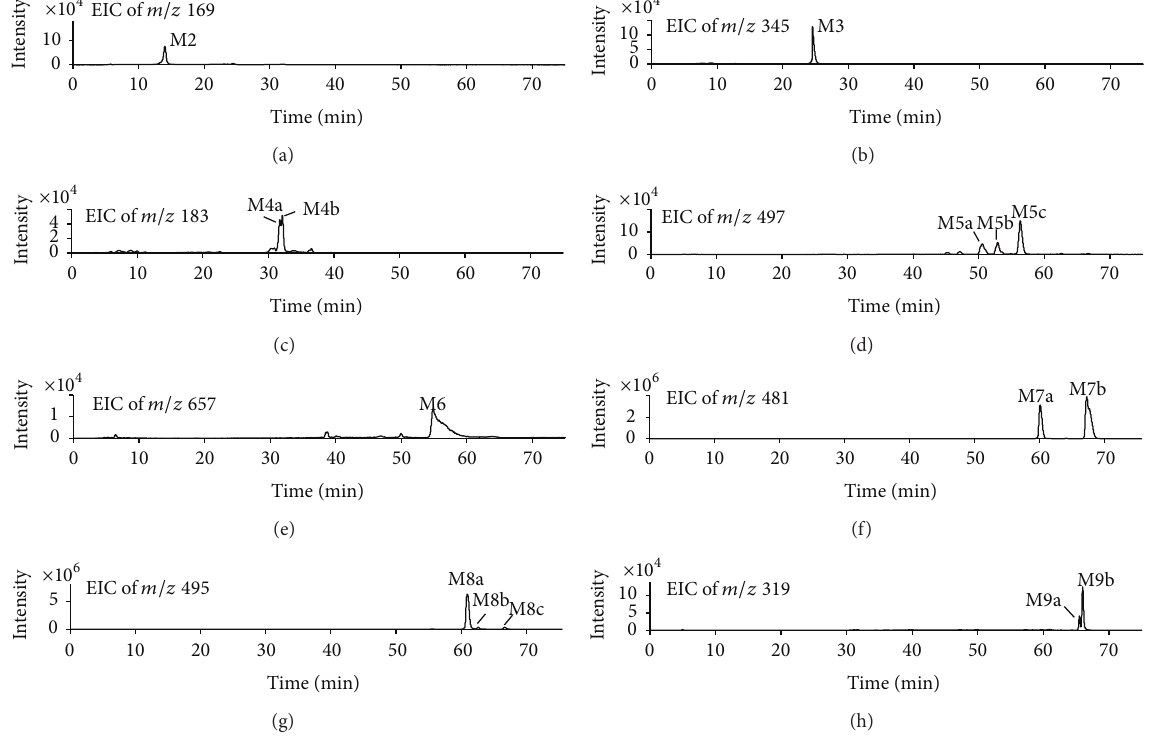
Figure 5: The extracted ion chromatograms (EICs) of in vivo metabolites M2 to M9 of BG in rat urine